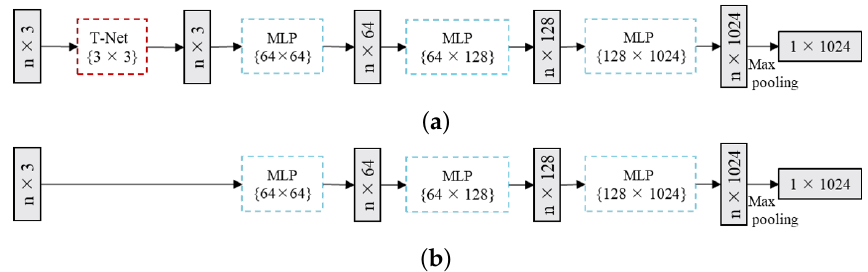
Figure 12. Comparison of PointNet structure and the PointNet network structure used in our FE layer: ( a ) Partical structure of initial PointNet. ( b ) Partical structure of PointNet used in our FE